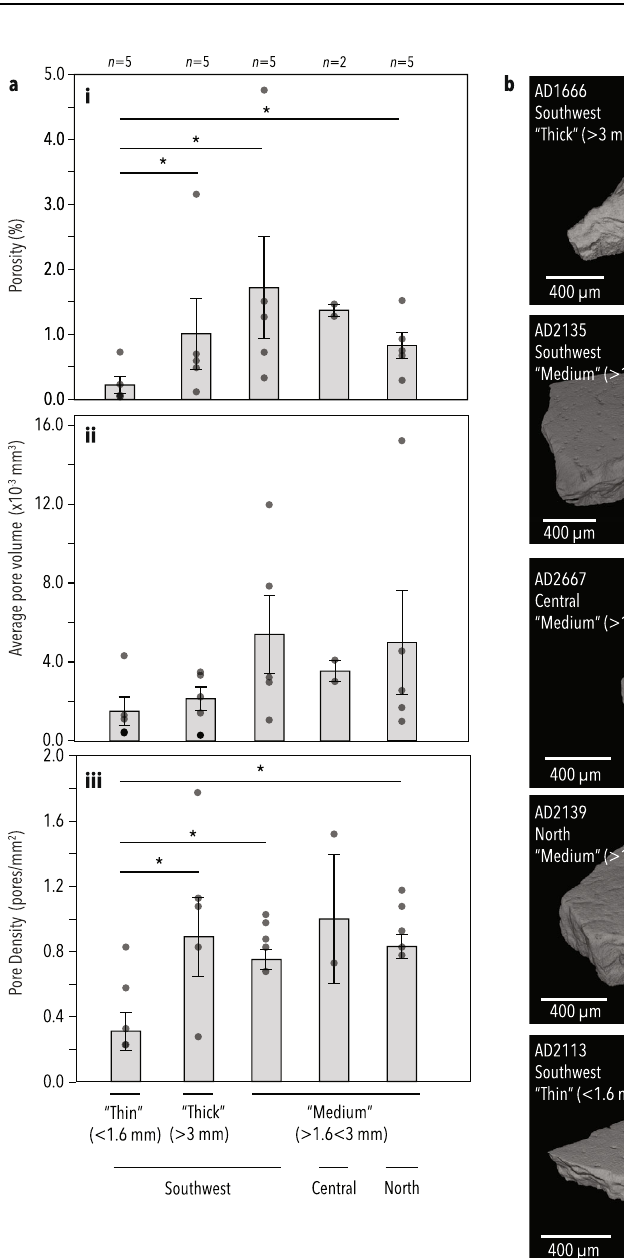
Fig. 2 | Molecular dated phylogenetic tree showing the mitochondrial rela- tionships between eggshell specimens from northern, central and southern Madagascar. a Consensus mitochondrial phylogenetic tree for all eggshell speci- mens sequenced here and genomes previously published from bone specimens. Nodes marked by an asterisk had the highest support from both ML and Bayesian analyses. Numbers beside nodes give the ML bootstrap support and Bayesian posterior probability for the topology. Unmarked nodes had ML support <70%. Superscripts beside specimens refer to the literature that previously published genetic data for these specimens. b Dated mitochondrial phylogeny for the palaeognathaegeneratedinMCMC tree using several representative elephant bird taxa(seealsoSupplementaryFig.3).Fossilcalibratednodesareindicatedbyaclock